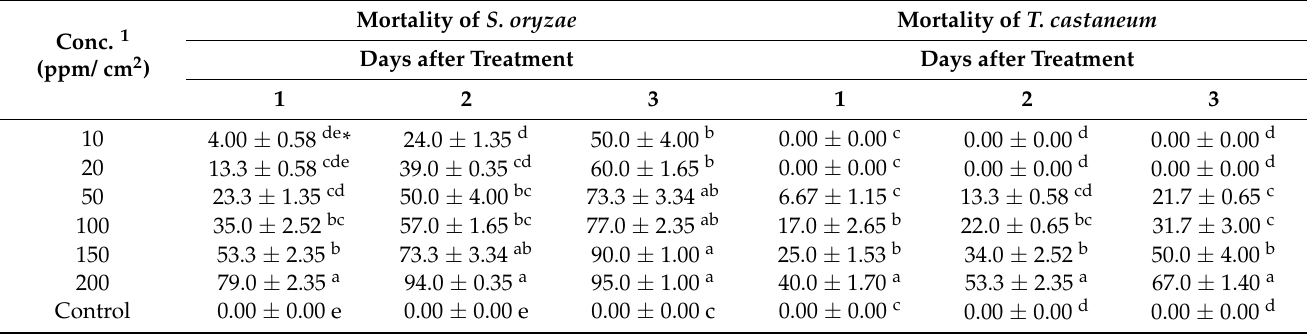
Table 4. Mortality ( ± SD) of S. oryzae and T. castaneum adults following contact bioassay of R. officinalis oil.